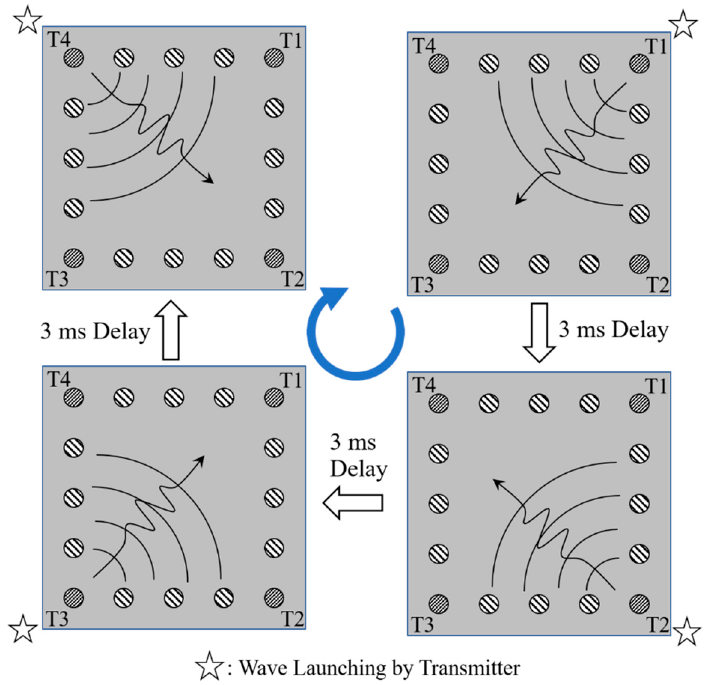
Figure 5. Complete cycle for launching acoustic waves into steel plate by four transmitters (T1~T4) with 3 ms time delay between them. The 12 receivers are synchronized to continuously receive wave signals over the 12 ms cycle.